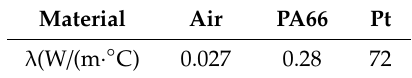
Table 4. Thermal conductivity coefficient of related materials.